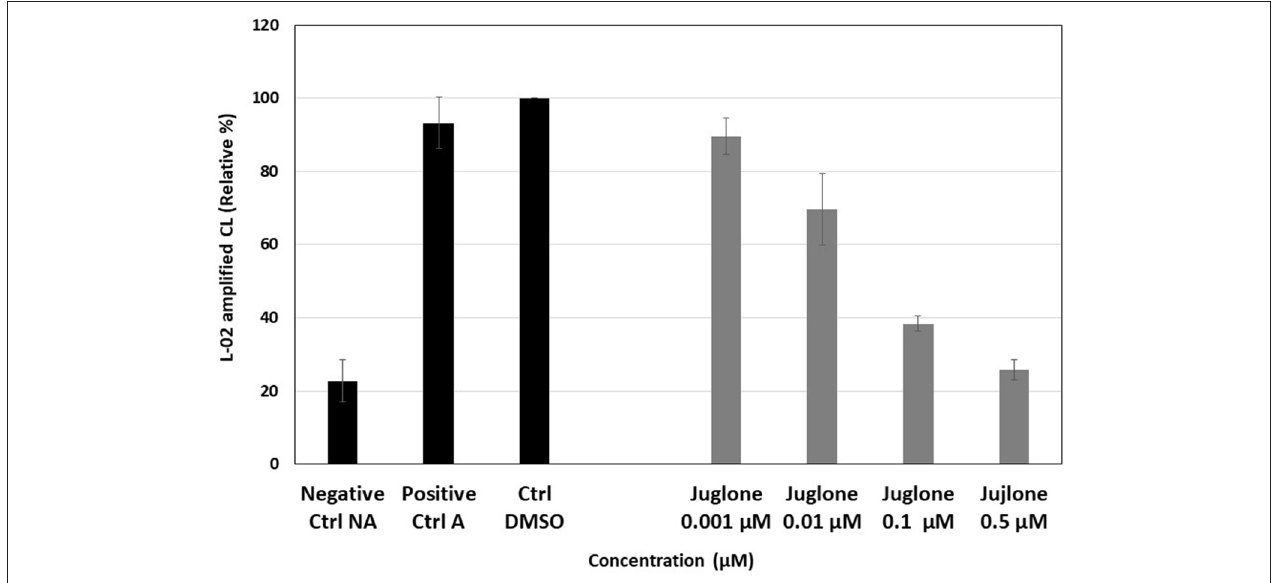
FIGURE 1 | Effect of increasing concentrations (0.001–0.5 µ M) of juglone on the reactive oxygen species (ROS) produced by phorbol myristate acetate (PMA)-activated neutrophils (1 million/well in PBS in the presence of 10mM calcium and the chemiluminescent probe, 10 − 4 M L-012). The results are the mean ± SD of triplicate experiments ( n = 6). Negative Ctrl (NA) , non-activated cells (no PMA); positive Ctrl (A) , PMA-activated cells ( + PMA ); Ctrl DMSO , control of activated cells with 1% DMSO taken as 100% of ROS